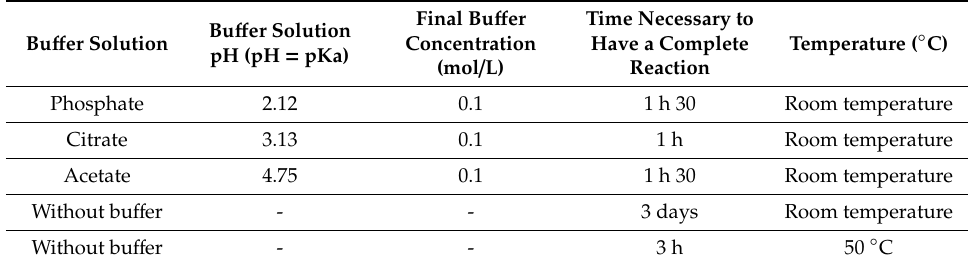
Figure 3. Reaction kinetic on 2000 µg L − 1 quality control for different derivatization conditions: in purple with phosphate buffer, in orange with citrate buffer, in green with acetate buffer and without adding acid in black (at room temperature) and in red (at 50 °C in a water bath). Table 1. pH, concentration, DNPH derivatization reaction time and temperature depending on buffer solutions added.